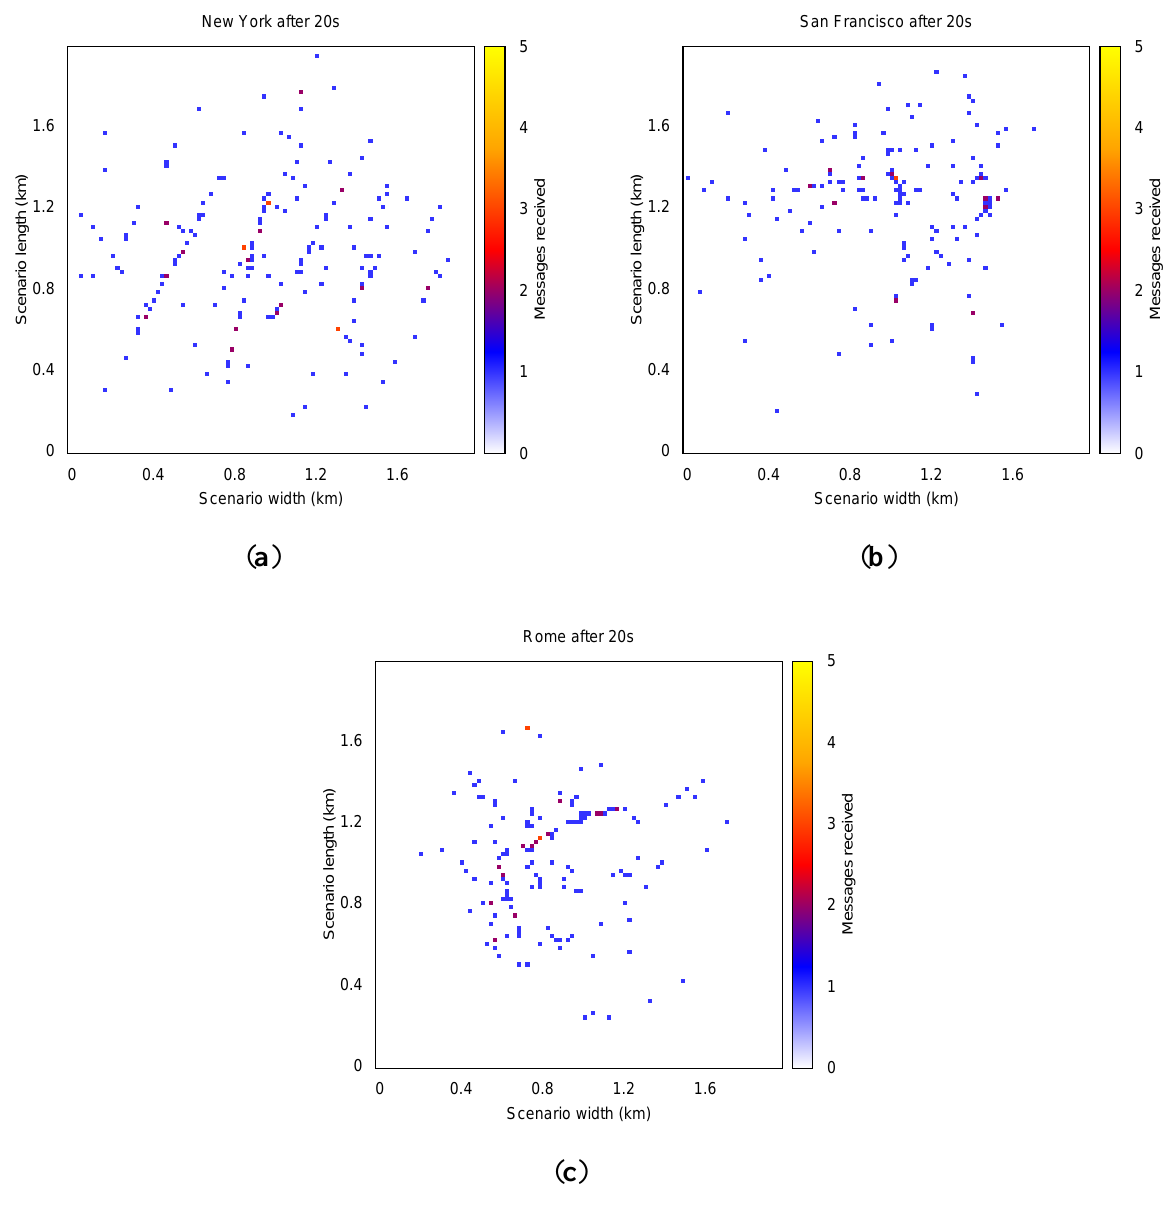
Figure 8. Evolution of the warning message dissemination process after 20 s, when simulating ( a ) New York; ( b ) San Francisco; and ( c ) Rome